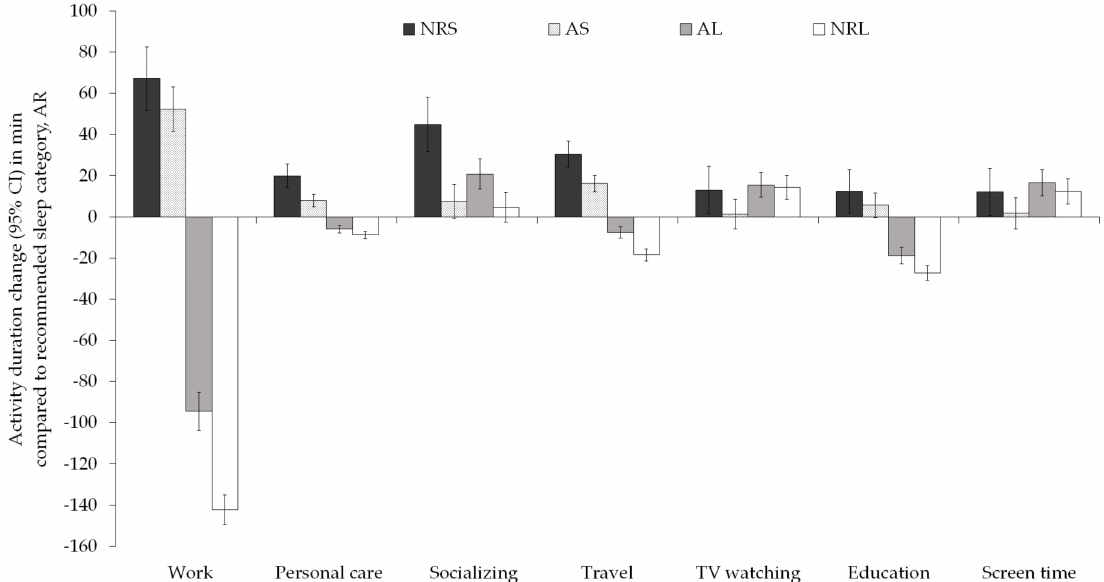
Figure 3. Adjusted deviation of duration of waking activity between nonadherence sleep duration categories (NRS, AS, AL, NRL) and the recommended sleep duration category (AR). AR—appropriate recommended duration; AS—appropriate but short; AL—appropriate but long; NRS—not recommended: too short; NRL—not recommended: too